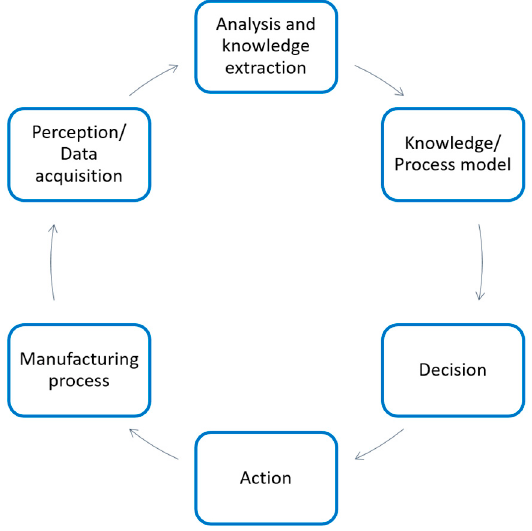
Figure 6. The cognitive process supporting self-optimization.